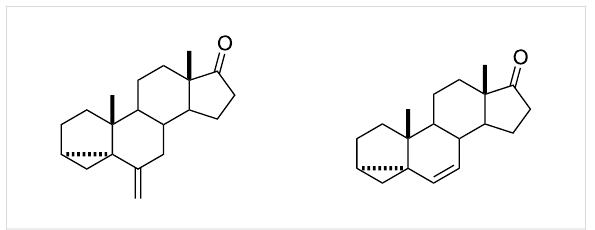
Figure 1: My two favorite compounds for my Ph.D. dissertation, “The Synthesis and Structural Examination of 3 α ,5-cyclo-5 α -androstane